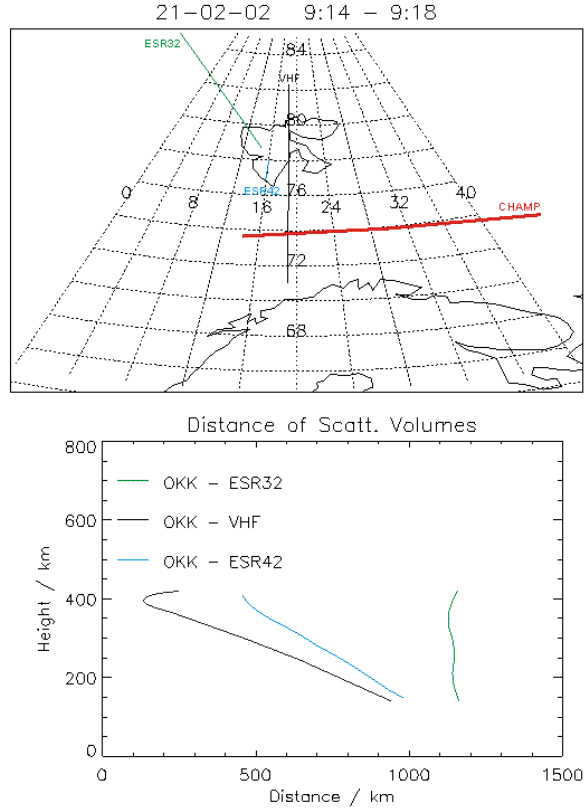
Fig. 1. Upper panel: Projection of the three radar beams and the occultation trace on the ground in a latitude-longitude graph. Lower panel: Distance between the occultation tangential point and the radar scattering volumes at same altitudes.